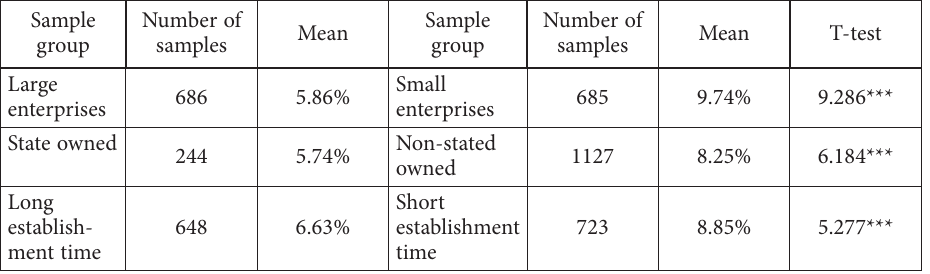
Table 6. Results of mean value